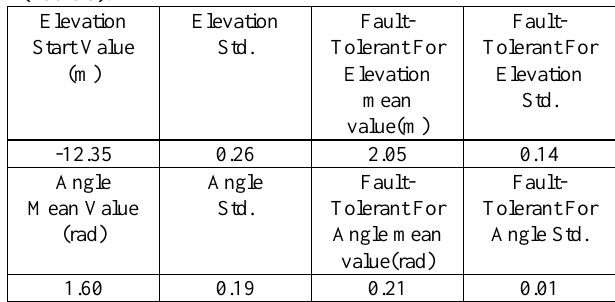
Table 3: Parameter setting for 8-neighborhood filling process Use part of the Island as example. Figure 11 shows the sandy beach extraction result. Figure 11 (a) (c) shows the good extraction accuracy of water/beach line while Figure 11 (b) (d) shows the extraction sifts out some non-beach points.